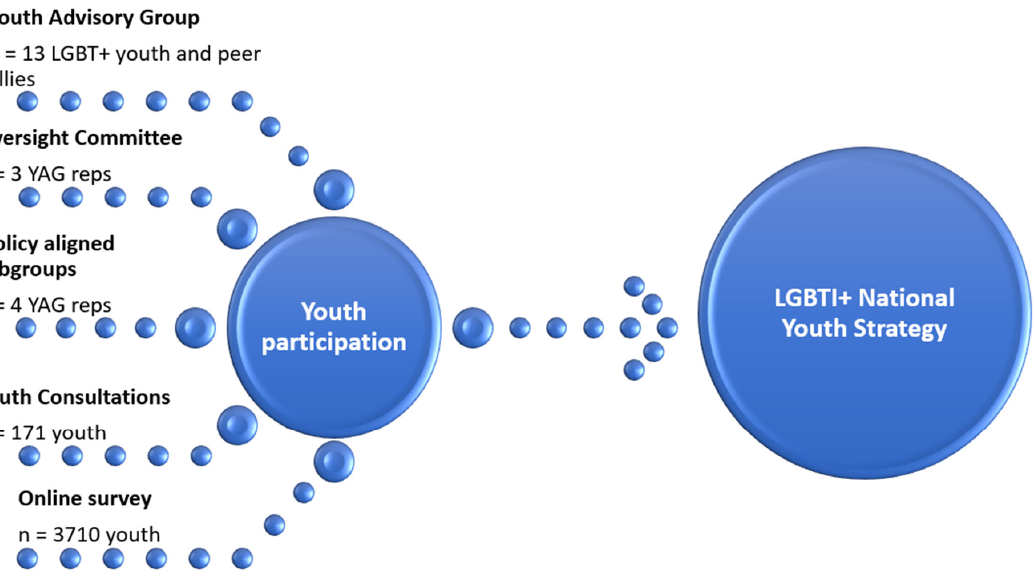
Figure 2. Prioritizing youth participation in the development of the Irish LGBTI+ National Youth Strategy.